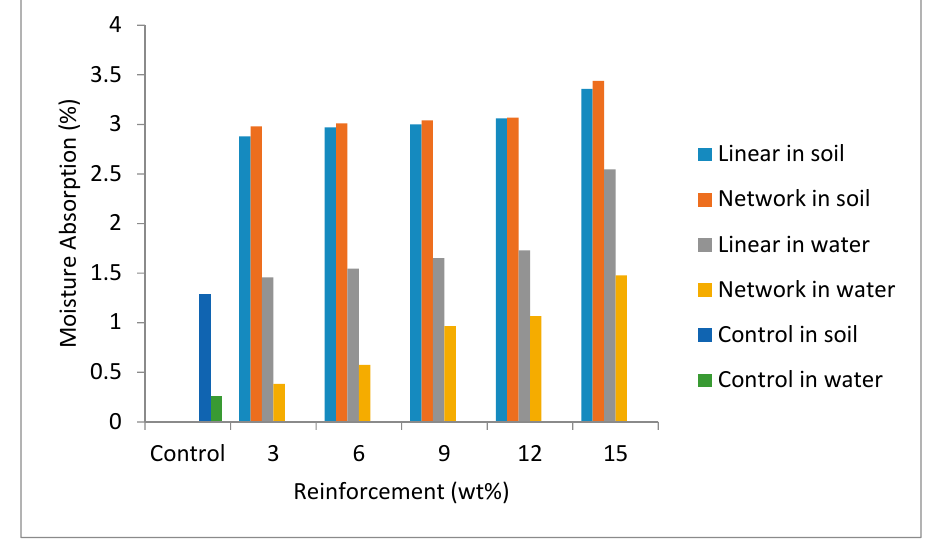
Figure 9. Variation of moisture content in water and soil for the developed composites and the control sample.